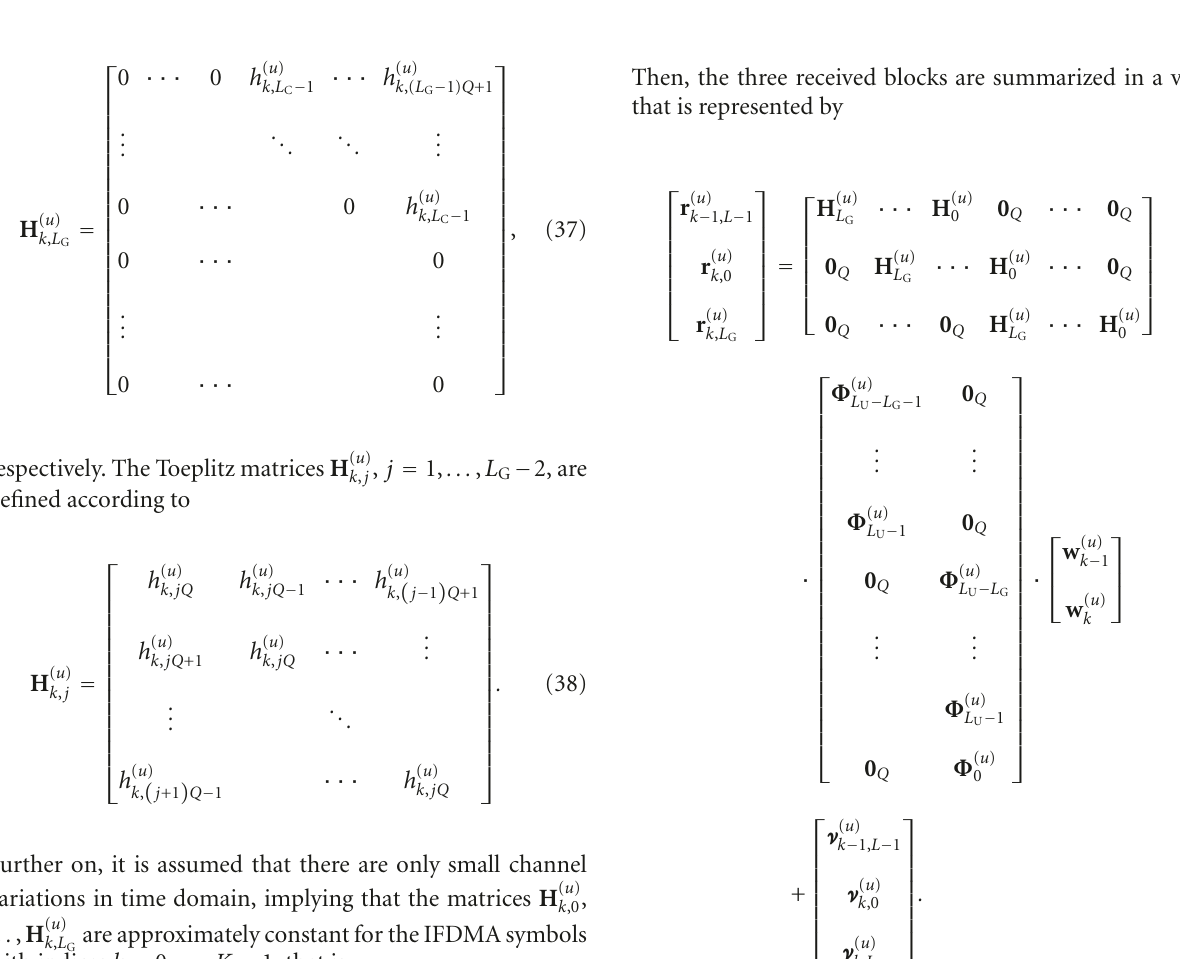
, r ( u ) k , and r ( u ) k . ,0 , L G 1, L − 1